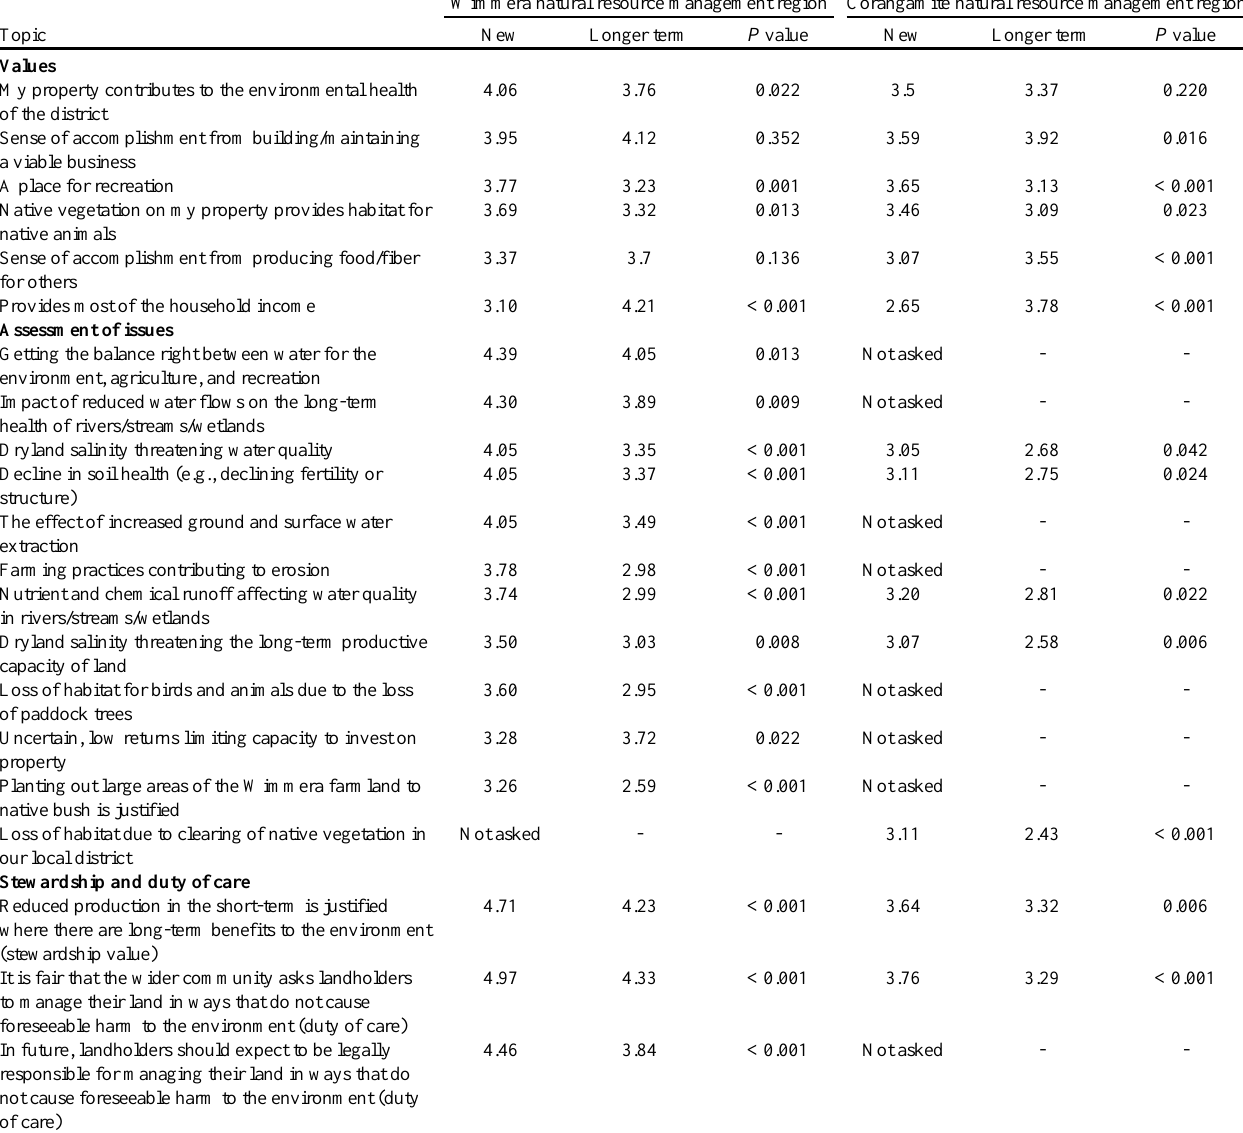
Table 3 . Comparison of newer (Wimmera region: n = 43–68; Corangamite region: n = 89–90) and longer term (Wimmera region: n = 176–388; Corangamite region: n = 358–363) landholders: values attached to property, assessment of issues, and value orientation. ( n denotes the number of respondents. Each item had a different number of respondents owing to missing values; these are indicated by the ranges in n